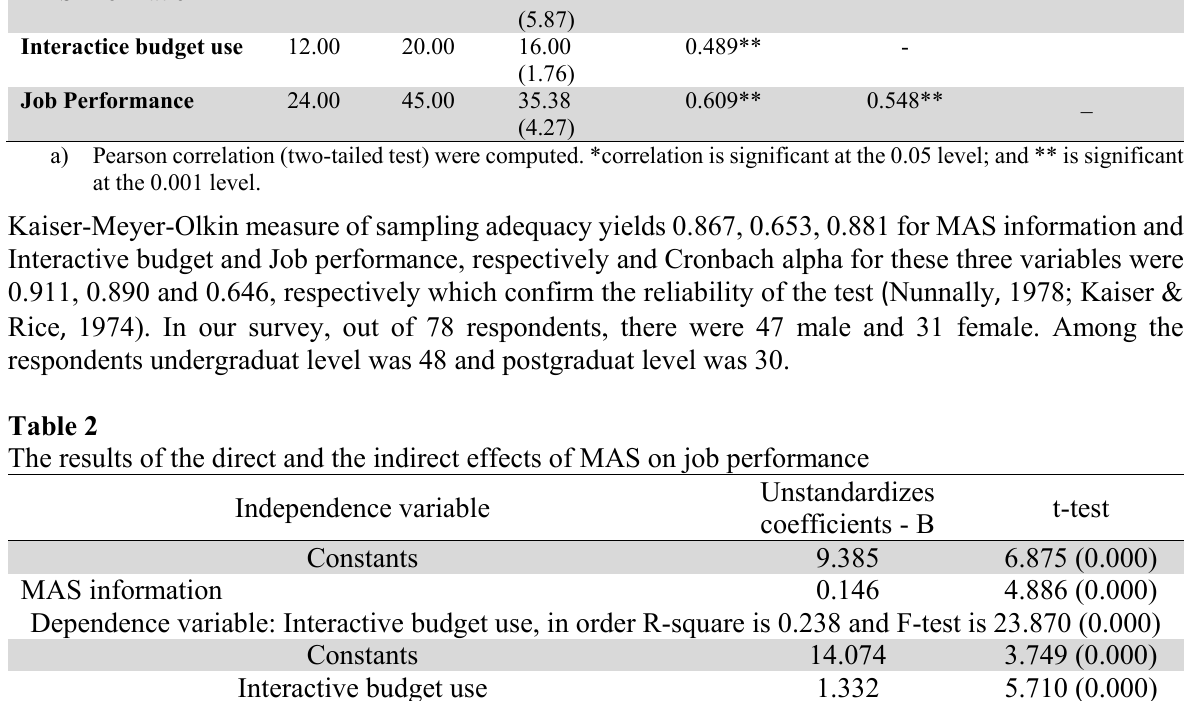
Descriptive statistics, reliability, validity, and correlation matrix a (n=78) Variables Min Max MAS information Interactice budget use Job Performance 24.00 0.548** _